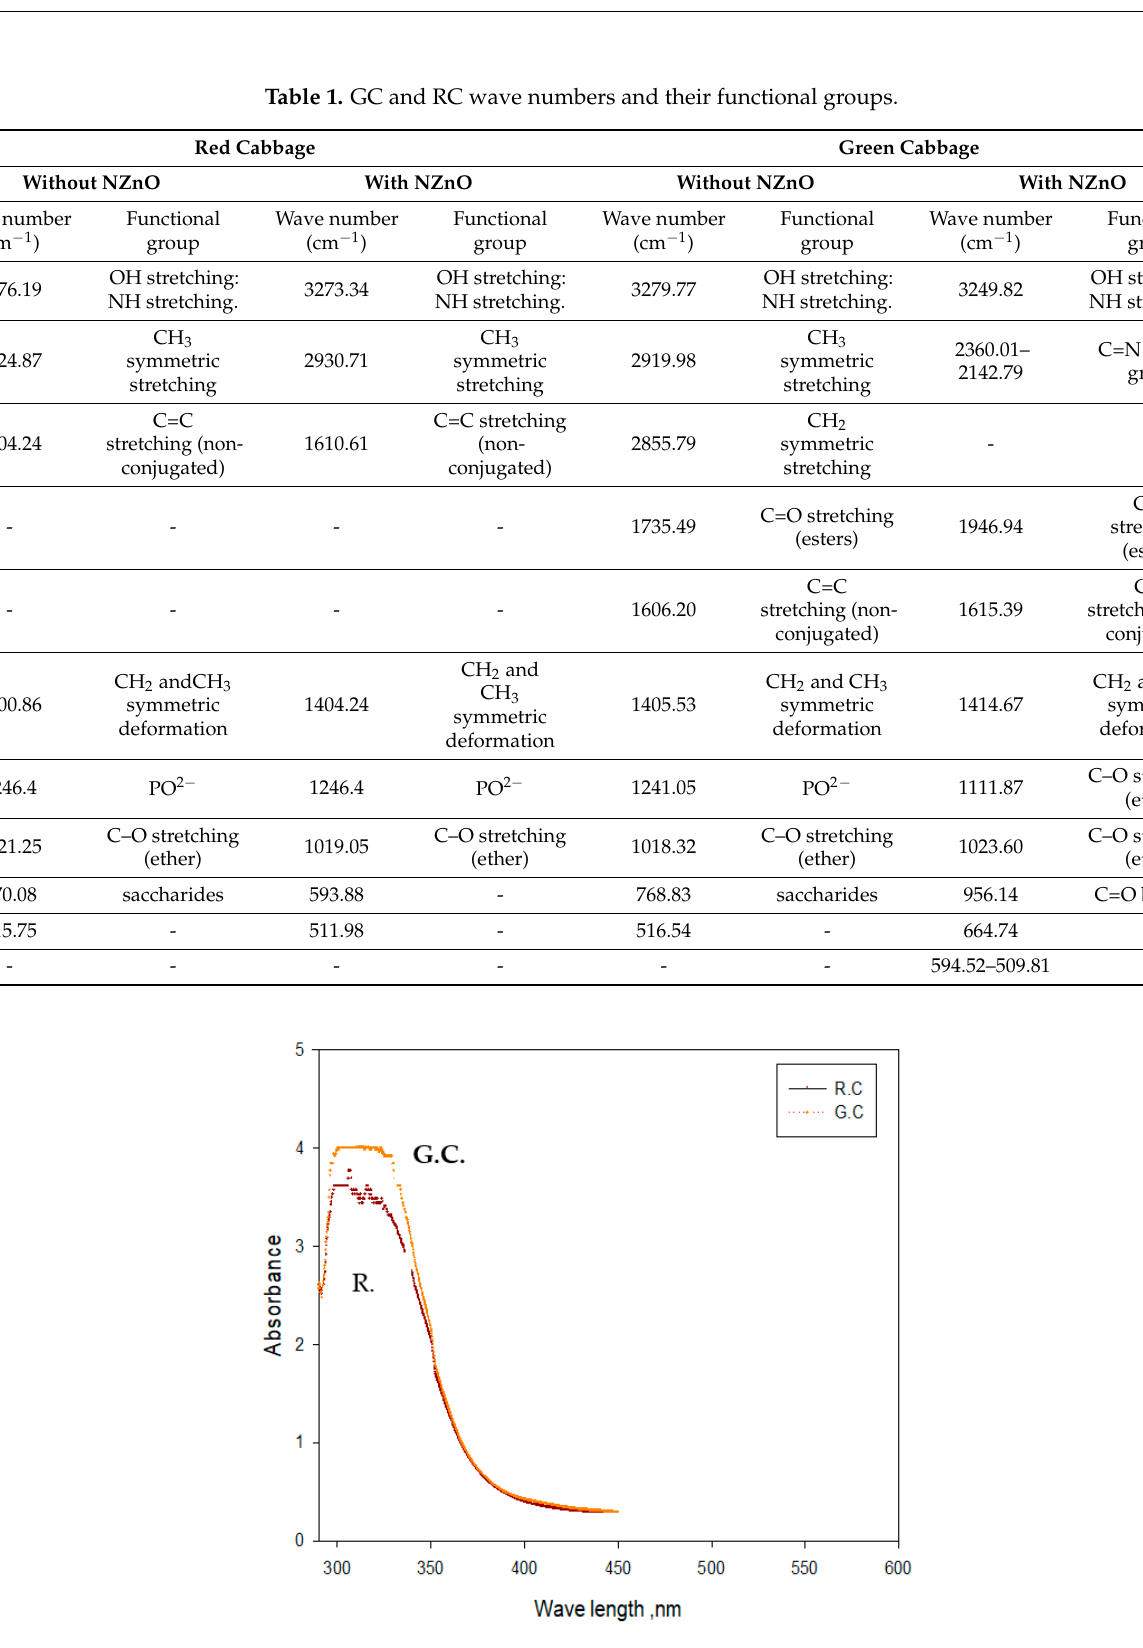
Figure 5. Variation of visible absorbance with the wavelength for red and green cabbage dyes.